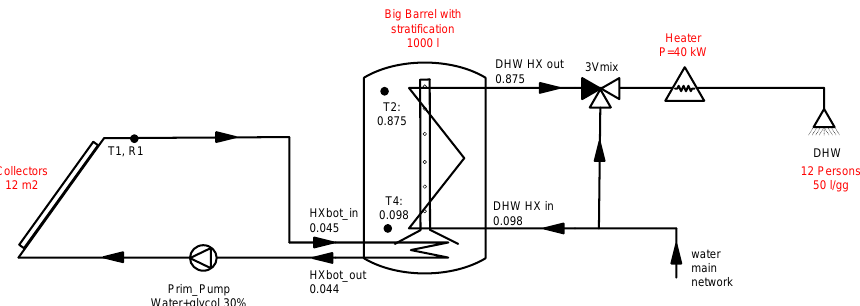
Figure 5. Layout of the solar domestic hot water (SDHW) system.